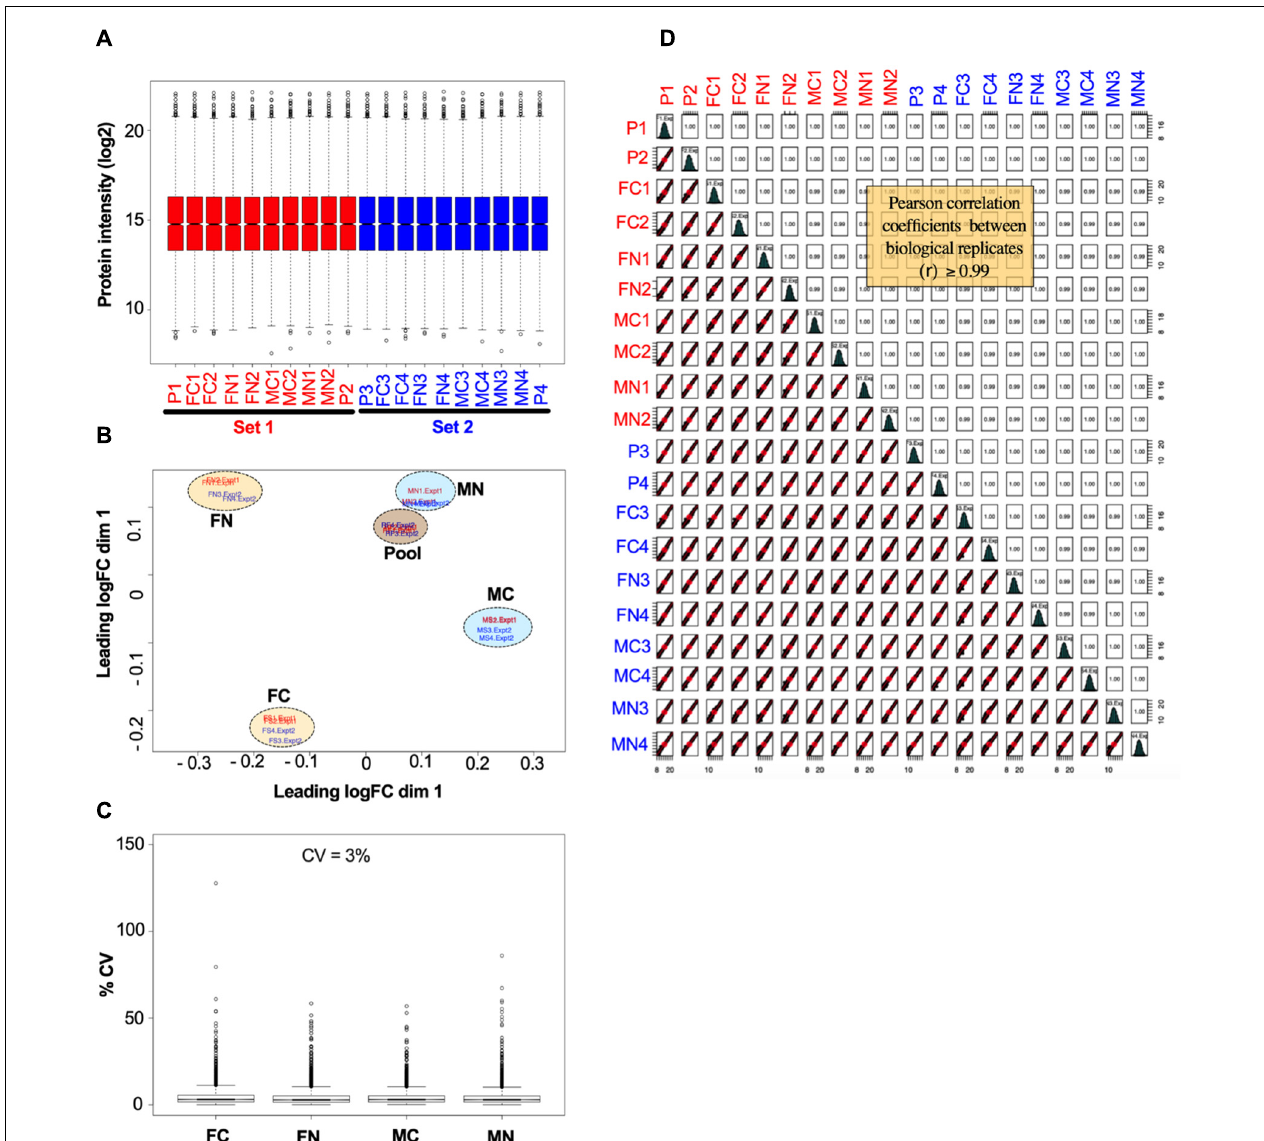
FIGURE 2 | Example of data normalization by sample loading, TMM, and IRS, using data from the VTA after chronic nicotine and withdrawal. (A) Normalized intensity values for each reference pool (P1, P2, P3, P4) and experimental sample in each of the two TMT experimental sets (red and blue) are shown as box plots. (B) Principal component analysis of sample intensity values shows clustering of the samples by experimental groups and reference pooled samples, where each oval encompasses the biological replicates run in each TMT experimental set. (C) The coefficients of variance of each experimental group averaged ∼ 3% after normalization. (D) Quality control analysis showing, for each biological replicate, scatter plots of normalized quantification values (log 2 of TMT intensities) and Pearson correlation coefficients, which ranged from 0.99 to